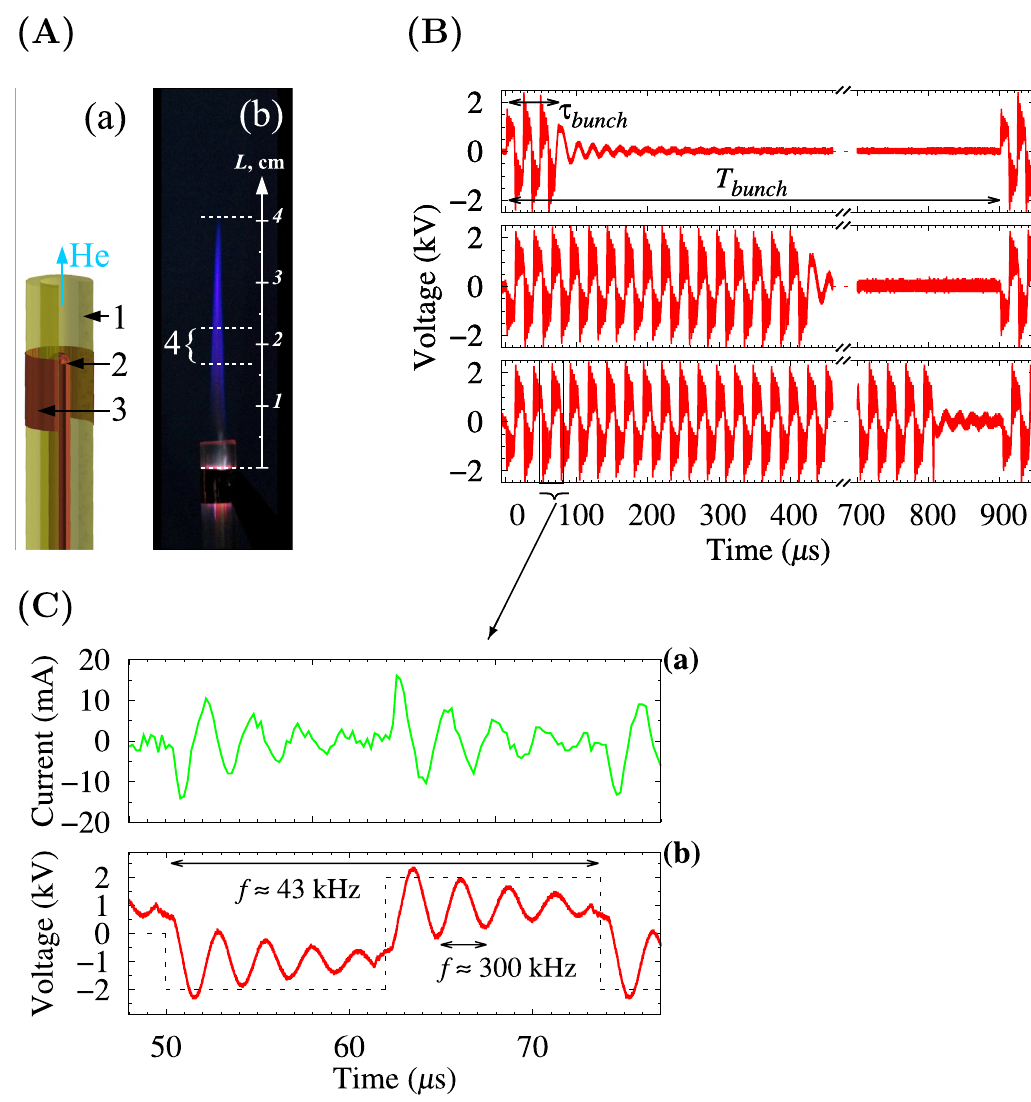
Figure 1. ( A ) Discharge unit ( a ) and photo of the plasma jet ( b ): 1—quartz tube, 2—high voltage rod electrode, 3—grounded foil electrode, 4—spectral intensity recording strip area of 6 mm width with centerline at 2.0 cm from the electrode edge; ( B ) Voltage signal across the discharge gap: ( a ) duty cycle of τ bunch / T bunch ≈ 8 %, ( b ) 50% and ( c ) 90%; ( C ) Current ( a ) and voltage ( b ) signal across the discharge gap during a voltage pulse